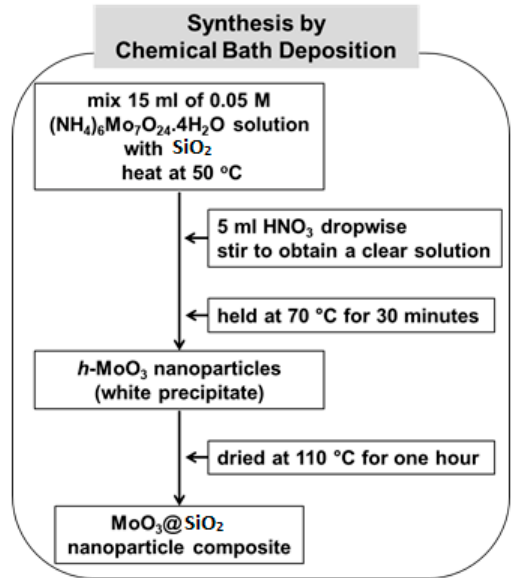
Figure 1. Illustration of the processing steps in the synthesis of MoO 3 @SiO 2 nanoparticle composites.